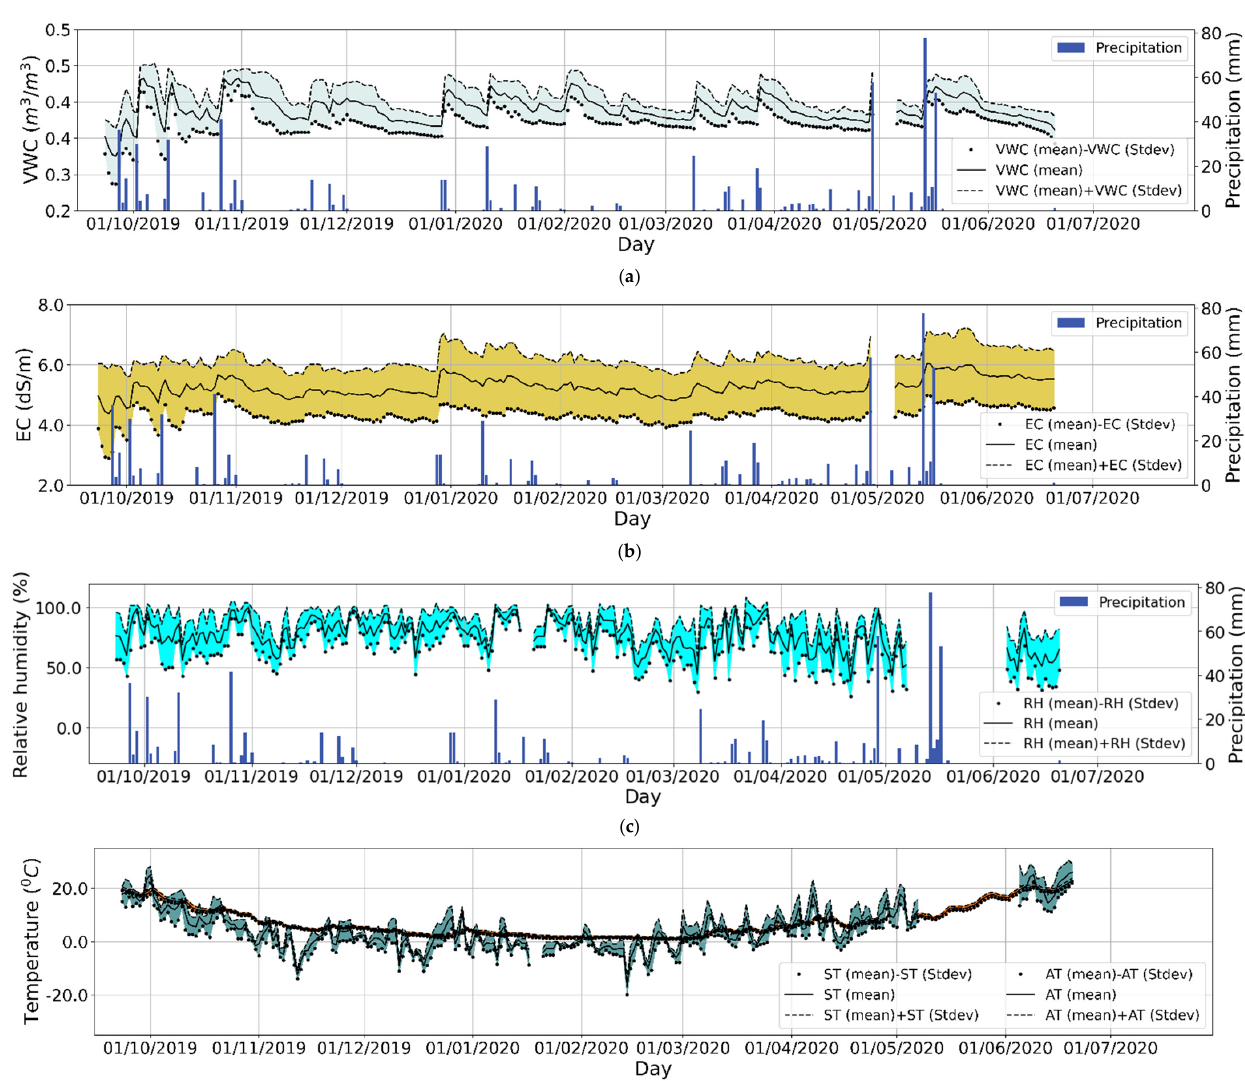
Figure 3. Daily mean averages ± standard deviation of soil volumetric water content (VWC) ( a ), electrical conductivity (EC) ( b ), relative humidity ( c ), and soil and air temperature ( d ). Relative humidity and air temperature measurements were collected from the weather station shown in Figure 2. Blue bars are cumulative daily precipitation events. Shadows indicates the ± standard deviation of the mean for VWC, EC, and RH.